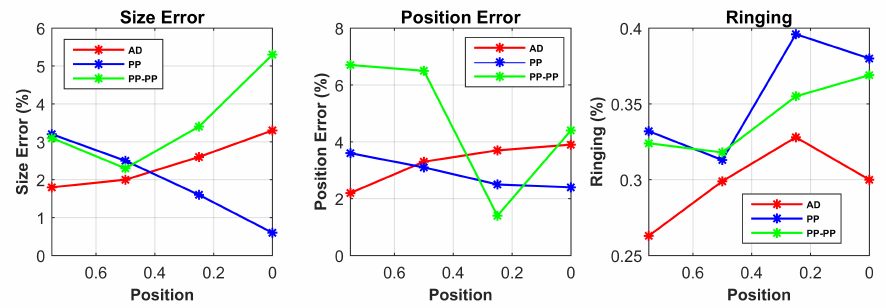
Figure 9. Performance parameters from experimental data are shown in the case of single point input